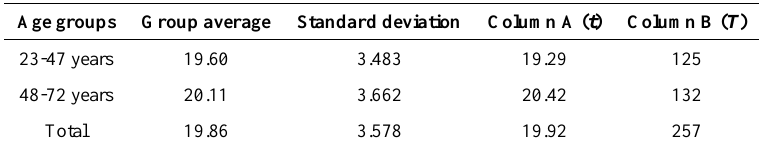
Table 1. Scores for the cognitive component – age